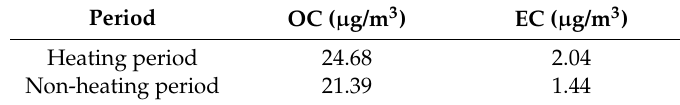
Figure 4. Heating and non-heating period variations of EC and OC concentration. Table 4. Average OC and EC concentration in PM 2.5 during heating and non-heating periods.